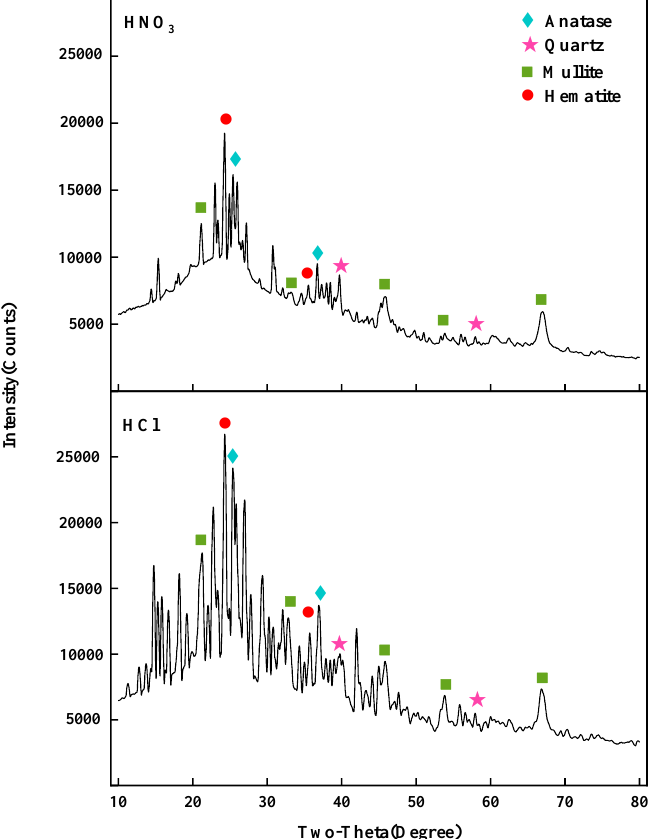
Figure 3. XRD patterns of the acid leaching residues.